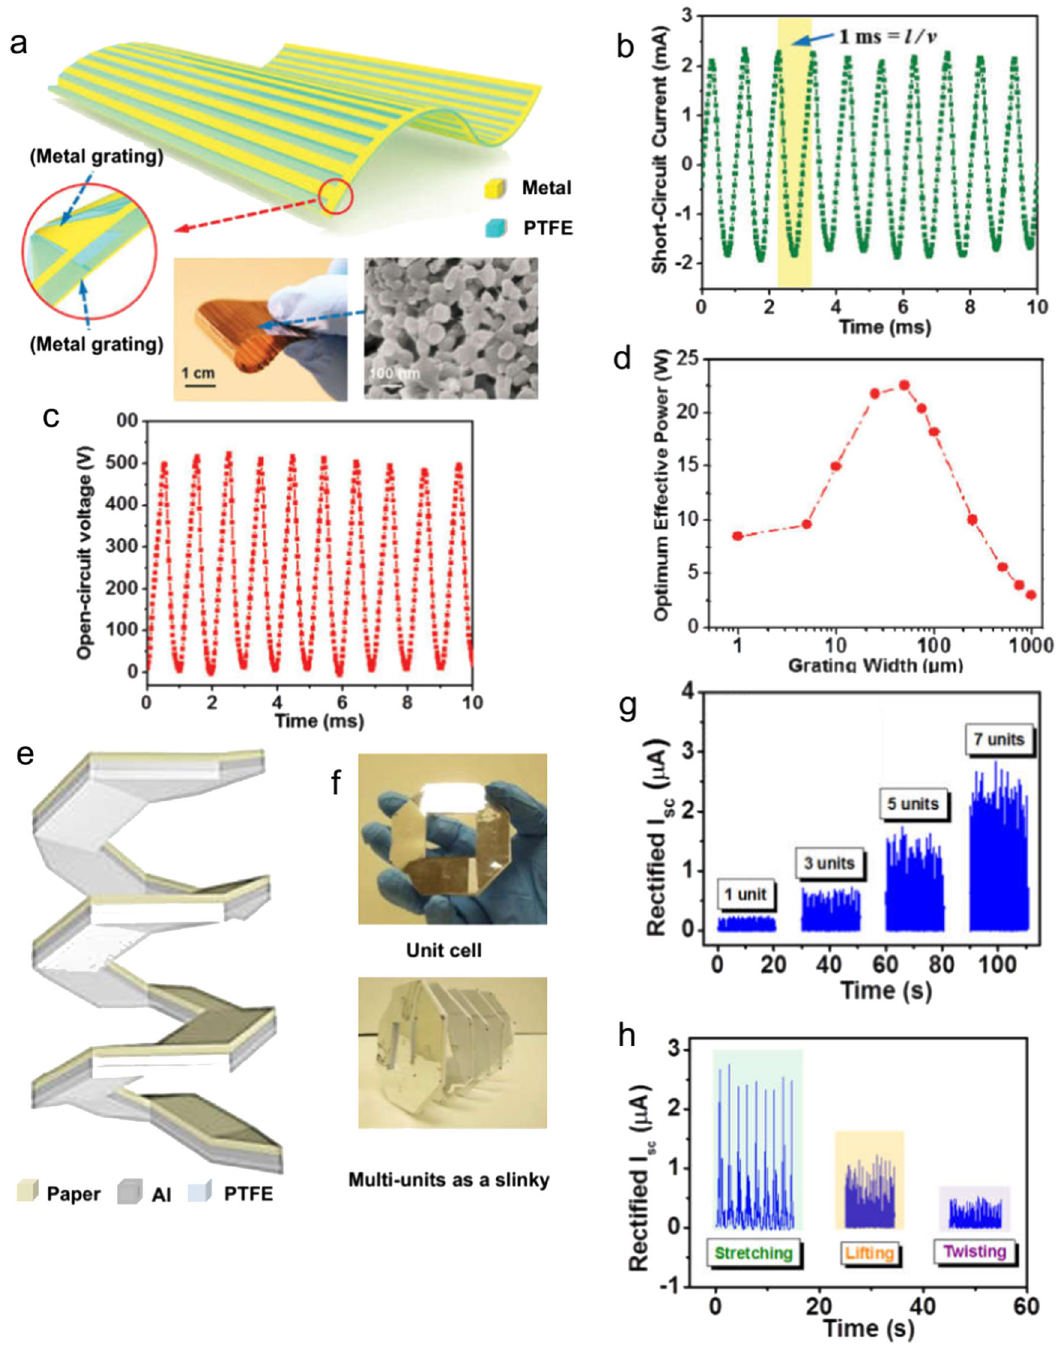
illustrations of the paper-based TENG. f Photograph of the unit cell and multiple units. g Dependence of output current on the number of connection units. h The output current under different human motion conditions. Reproduced with permission. 31 Copyright 2016